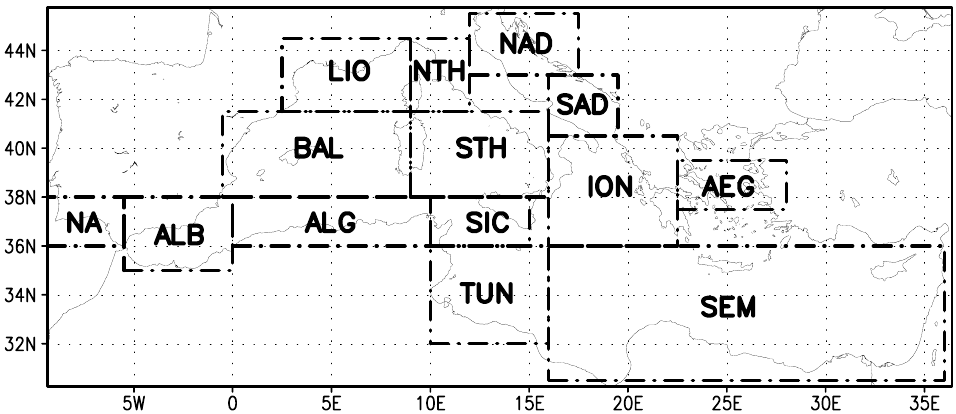
Fig. 8. Areas’ subdivision: North Atlantic box (NA), Alboran Sea (ALB), Gulf of Lions (LIO), Balearic Basin (BAL), Algerian Sea (ALG), North Tyrrhenian Sea (NTH), South Tyrrhenian Sea (STH), Sicily Strait (SIC), Tunisian/Lybian Sea (TUN), North Adriatic Sea (NAD), South Adriatic Sea (SAD), Ionian Sea (ION), Aegean Sea (AEG), South-East Mediterranean Sea